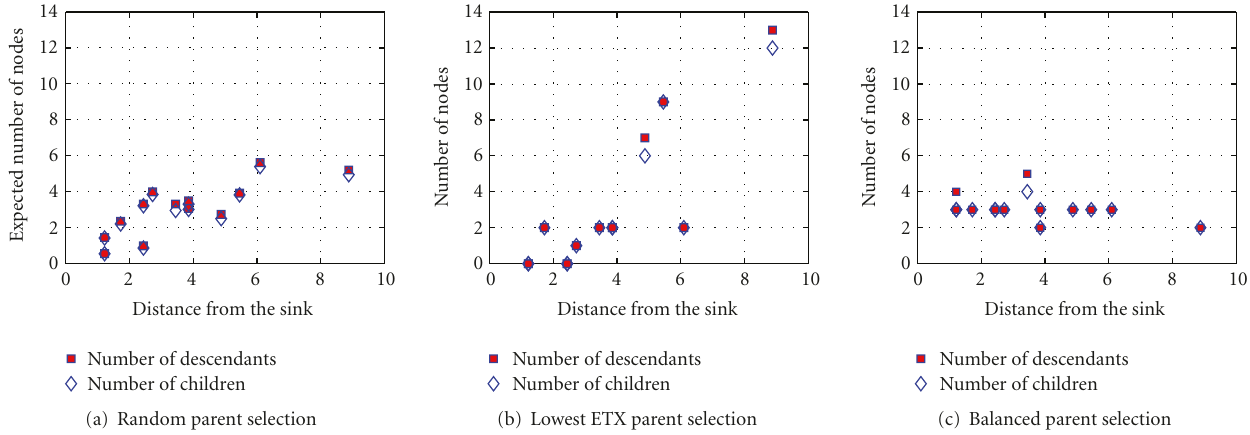
Figure 4: The number of descendants for the first-hop level nodes as a function of their distance to the sink under three parent selection schemes with MHR.